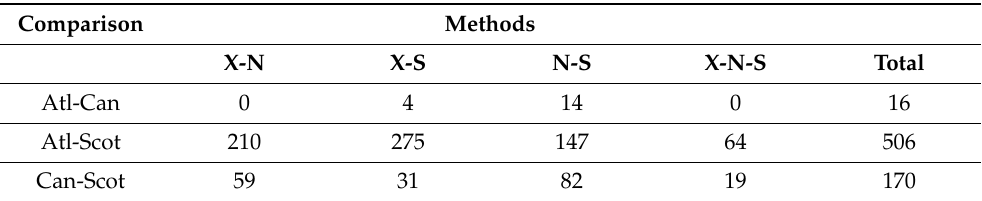
Table 3. Number of significant SNPs in at least two haplotype-based methods for each comparison. Comparisons: Atl-Can: Atlantic–Cantabric; Atl-Scot: Atlantic–Scotland; Can-Scot: Cantabric–Scotland. Methods: X: XP-EHH; N: nvdFST; S: SmileFinder. Total: total number of different SNPs